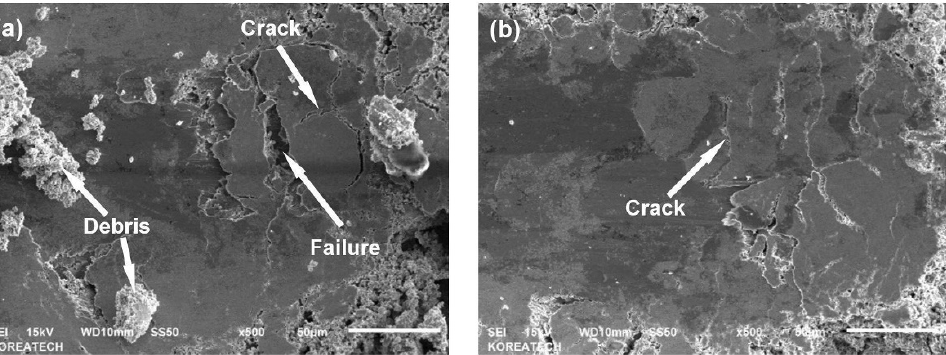
Figure 15. The surface morphology of the ( a ) base and ( b ) USNM’ed HVOF SAE 52100 bearing steel. Reprinted with permission from ref. [111]. Copyright 2021, Elsevier.